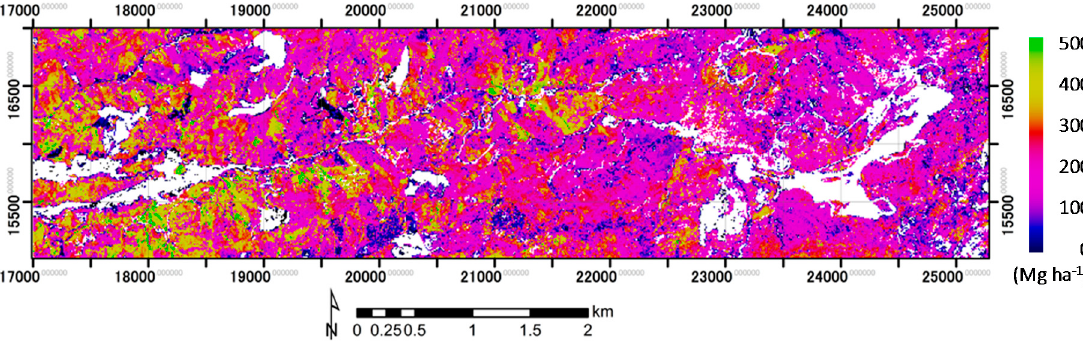
Figure 8. Distribution of TDB using Equations (2) and (8). The white areas are non-forested.